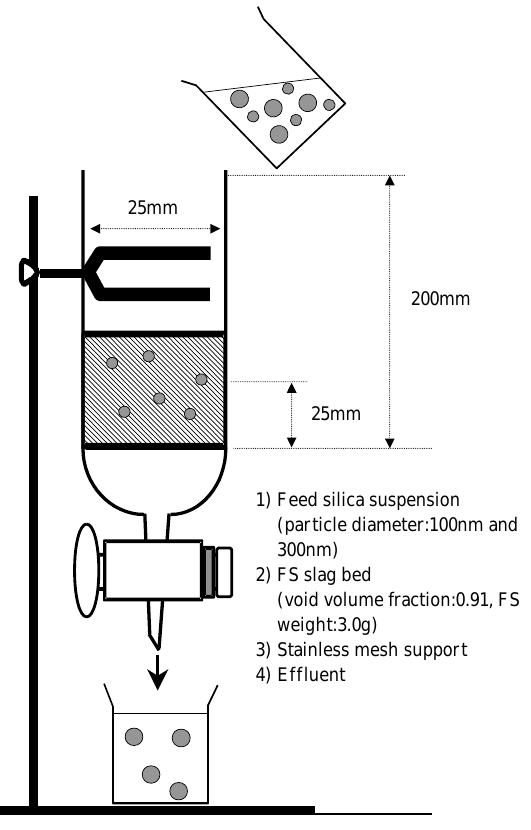
Fig. 3 Zeta potential measurement of silica and slag as a function of pH in 10mM KNO 3 Fig. 2 Illustration of FS-packed column